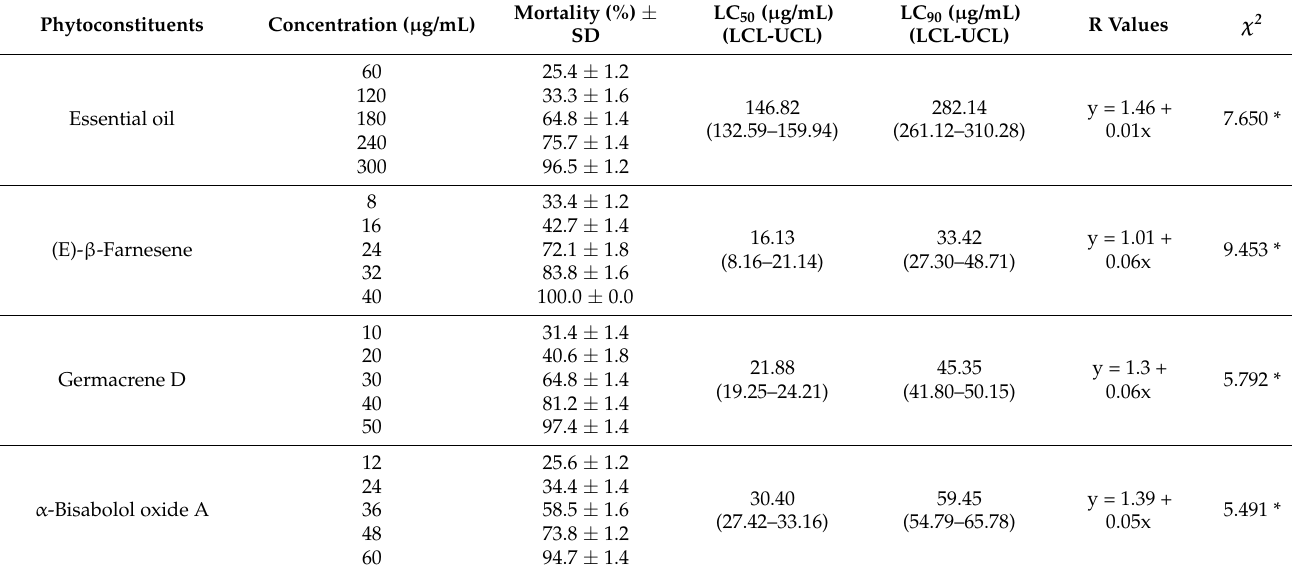
Table 2. Larvicidal activity of Matricaria chamomilla essential oil and its major phytoconstituents against 3rd-instar larvae of Spodoptera litura .